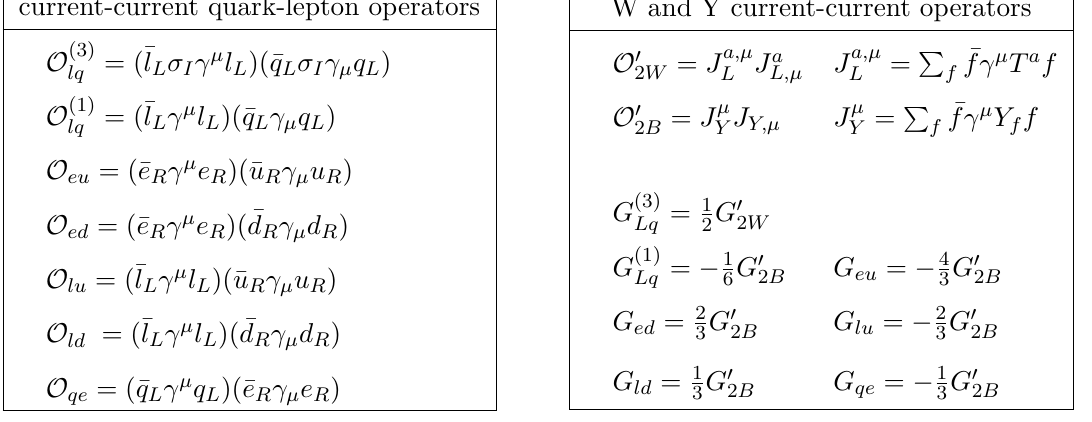
Table 1 . Left table: quark-lepton current-current operators in the Warsaw basis [28]. The operators are flavor universal and thus the generation indices have been suppressed. Right table: the operators related to the W and Y parameters, together with their rewriting in terms of Warsaw basis